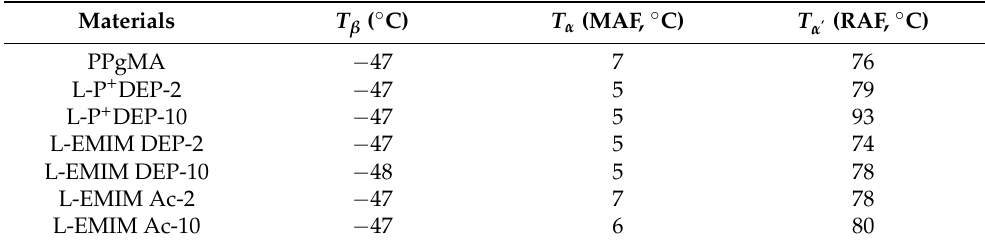
Table 2. Temperatures at the maximum of tan δ at 1 Hz of the β , α and α ’ relaxations of neat PPgMA and associated